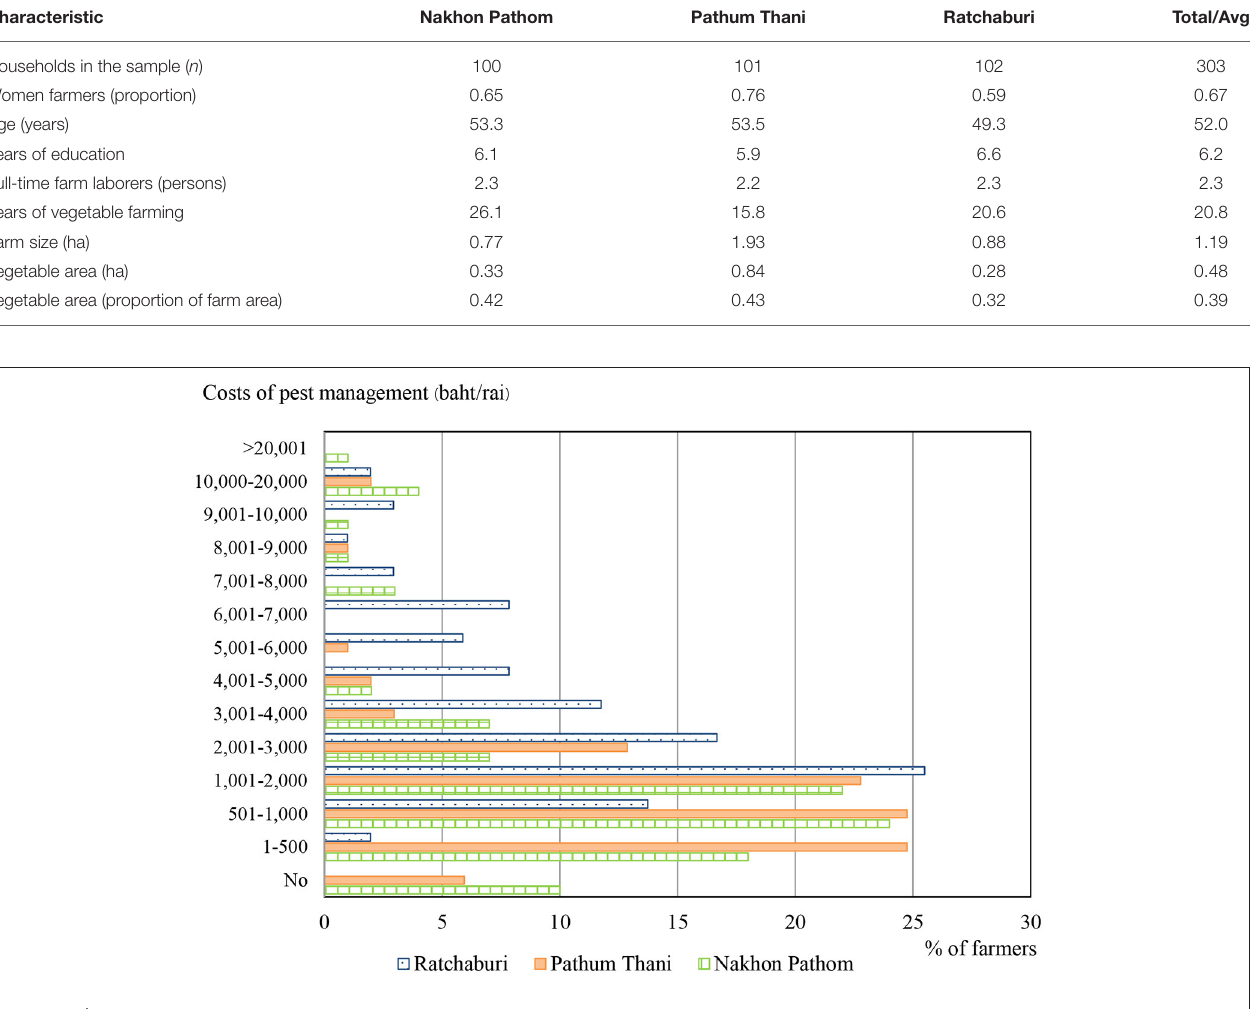
Pathom at 2,390 baht/rai (466 USD/ha) and farmers in Pathum Thani at 1,550 baht/rai (302 USD/ha). Most farmers spent < 2,000 baht/rai (390 USD/ha) ( Figure 3